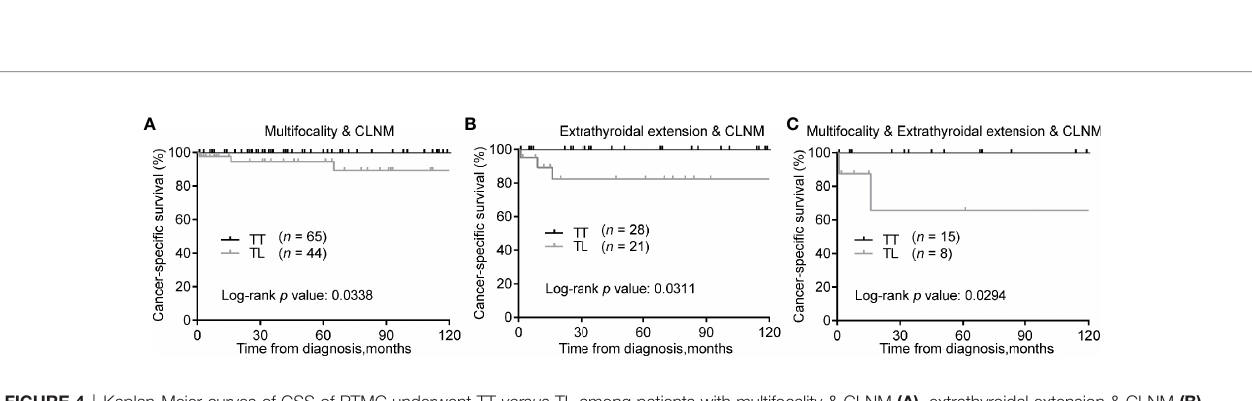
FIGURE 4 | Kaplan-Meier curves of CSS of PTMC underwent TT versus TL among patients with multifocality & CLNM (A) , extrathyroidal extension & CLNM (B) , and multifocality & extrathyroidal extension & CLNM (C) after propensity score matching. CSS, cancer speci fi c survival; PTMC, papillary thyroid microcarcinoma; TT, total thyroidectomy; TL, thyroid lobectomy; CLNM, cervical lymph node metastasis.